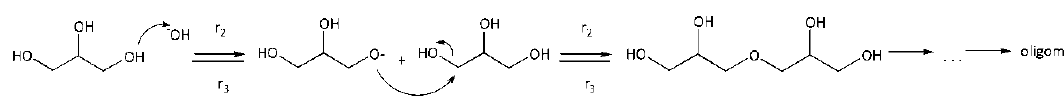
Figure 5. A schematic conversion of glycerol into diglycerol in the volume.